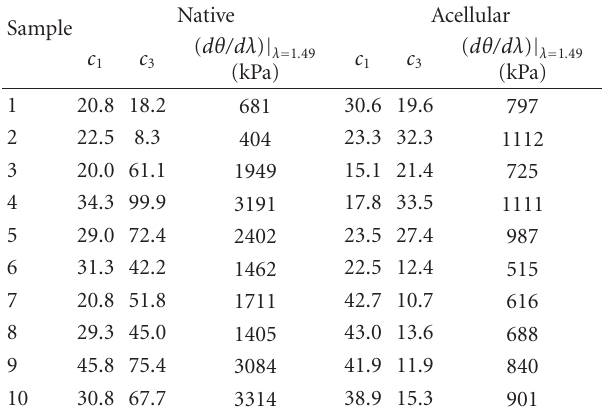
Table 4: Extended data for Protocol A.